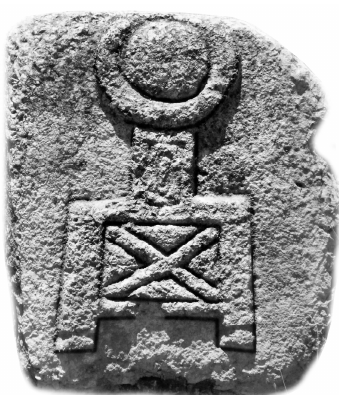
Figure 3. Lunar crescent relief from one side of the entrance to the Rujm al-Kursi building. Photo courtesy of the author.